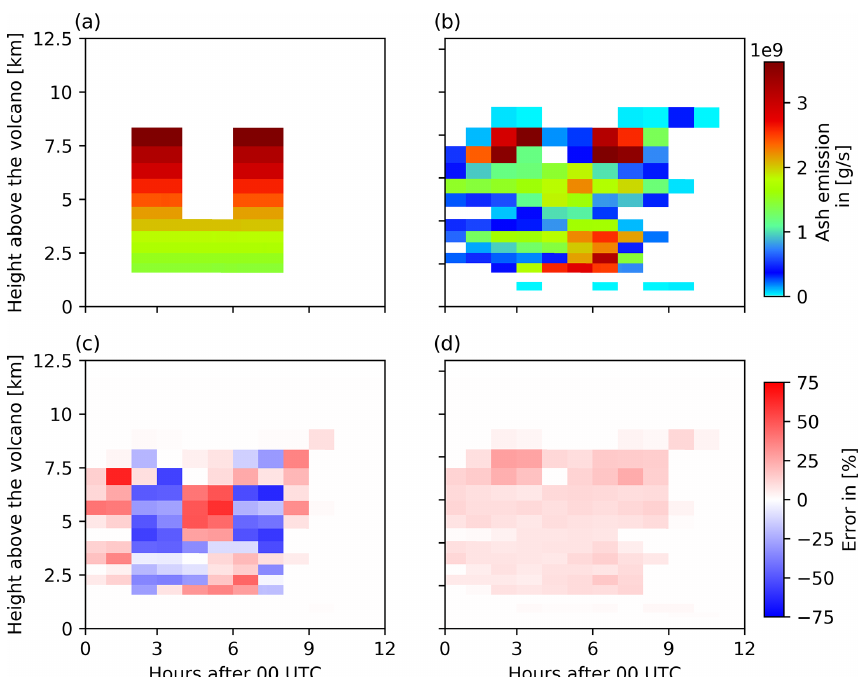
Figure 10. Comparison of the emission profiles of the nature run and ensemble mean for 29 April 2010. The figure shows (a) the nature run emission profile and (b) the ensemble mean emission profile. For comparison, (c) the relative error of the ensemble mean and (d) the relative ensemble standard deviation are